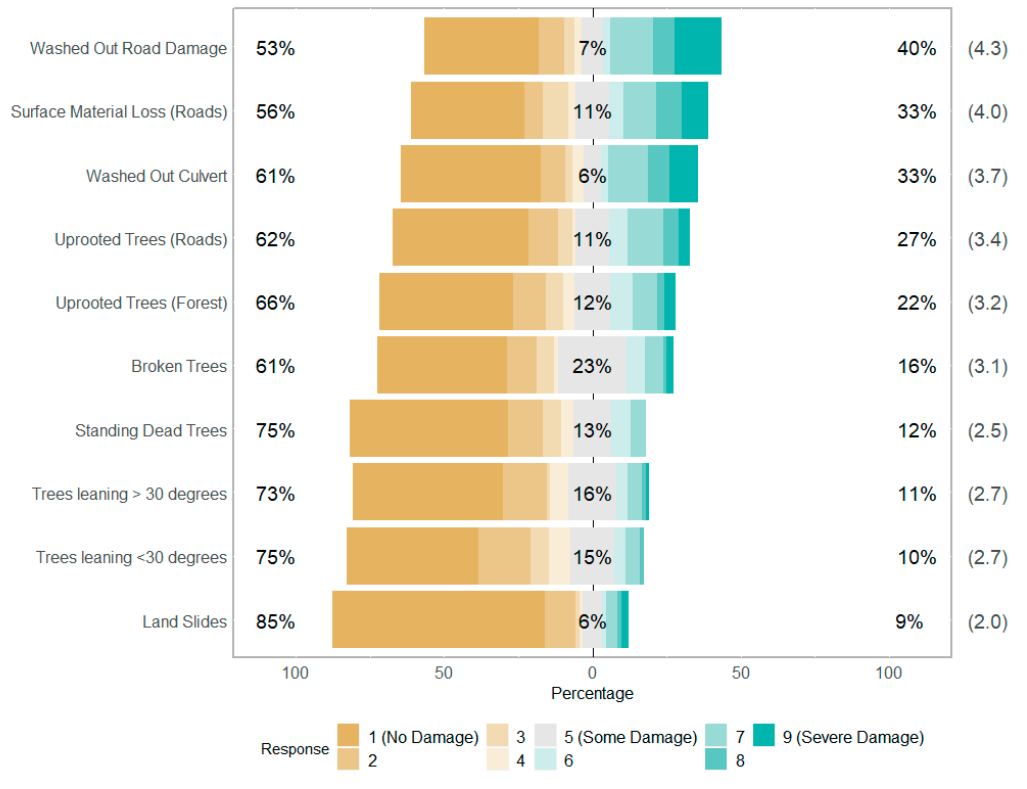
Figure 4. Percent of South Carolina Tree Farmers in 45 counties indicating damage (9-point Likert scale where 1 = no damage, 5 = some damage and 9 = severe damage) on the property that sustained the most damage from the 2015 flood (June–August 2017 data collection). Values in parentheses represent mean response values. Percent values to the left show the fraction of respondents that reported low damage (values 1 to 4) for the particular damage item, the percent values in the center show the fraction of respondents that reported some damage (value 5), and the percent values to the right show the fraction of respondents reporting high damage (values 6 to 9).